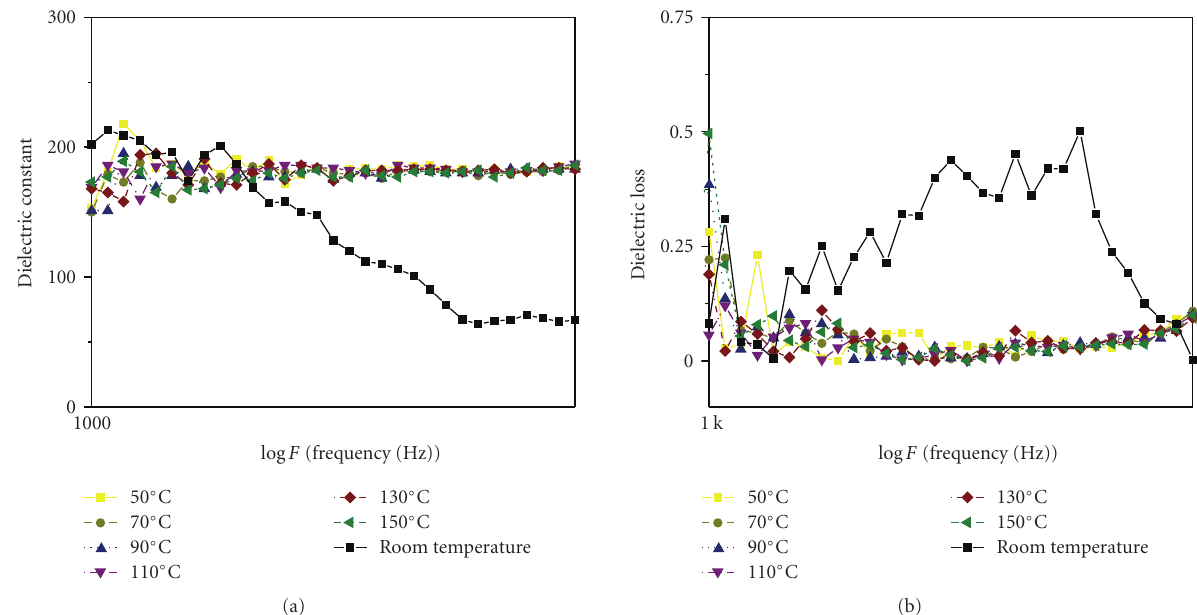
Figure 19: (a) Dielectric constant of L-threonine. (b) Dielectric loss of L-threonine.